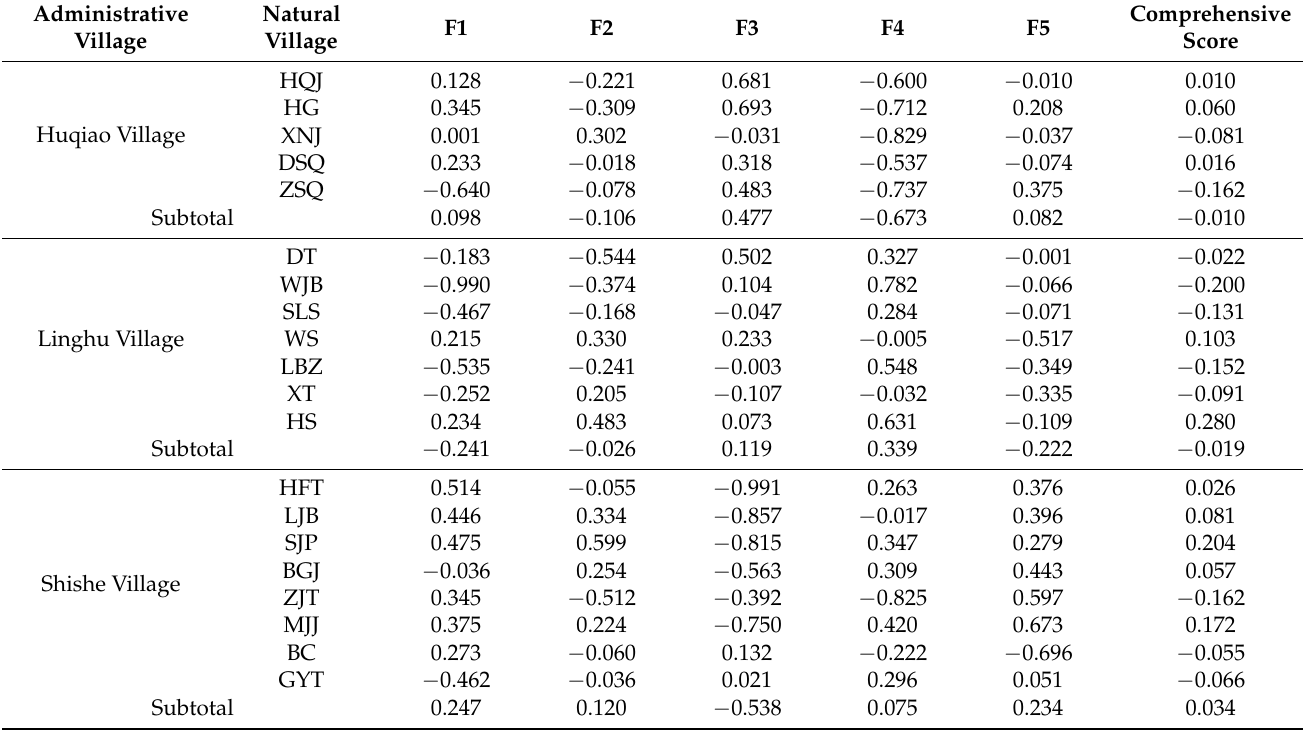
Table 5. Common factors and comprehensive scores of each